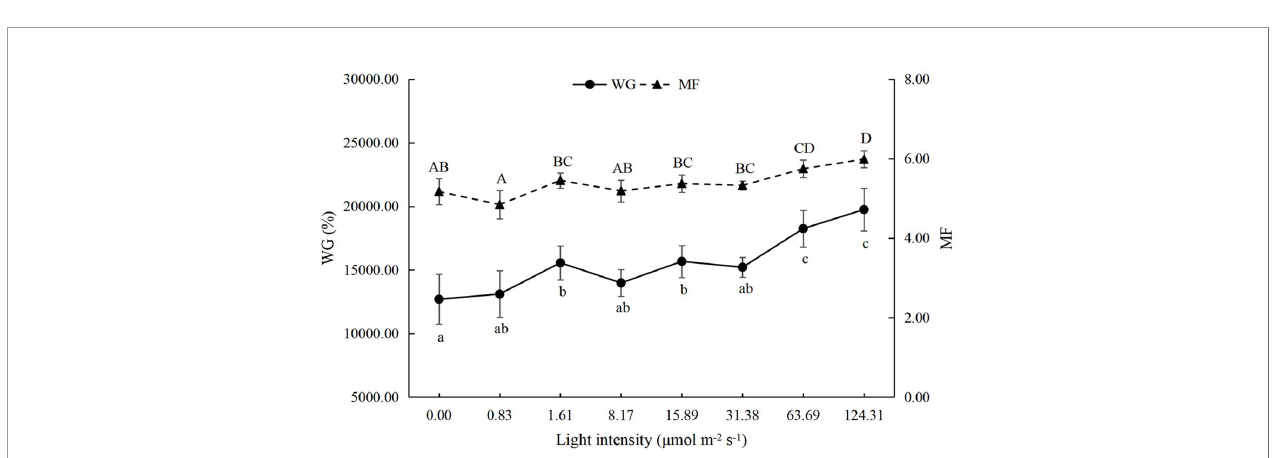
FIGURE 1 | Effect of different light intensities on the survival and special growth rate (SGR) of juvenile Portunus trituberculatus (mean ± SD, n = 4). Different lowercase and capital letters indicate signi fi cant differences ( P < 0.05) in survival and SGR, respectively.